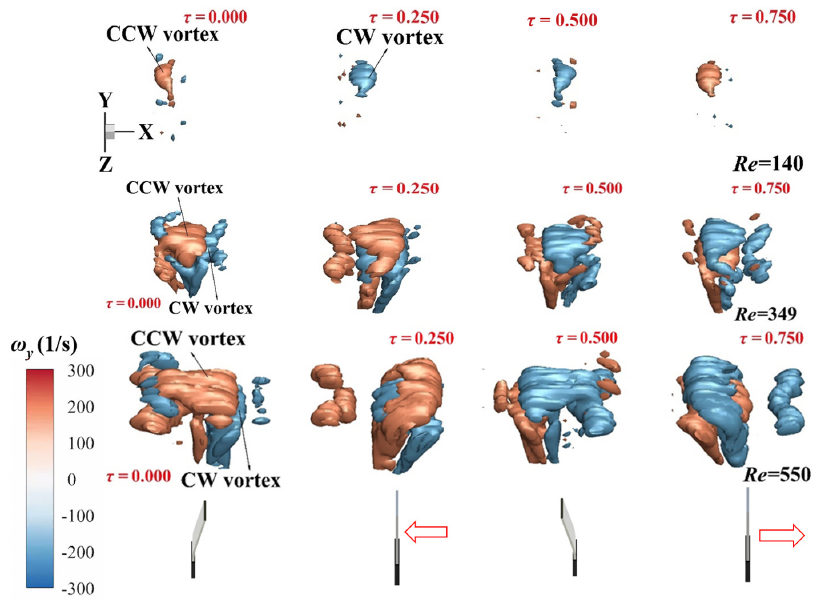
Figure 14. Temporal evolution of vortex in an oscillation period in 3D at different Reynolds num- bers.